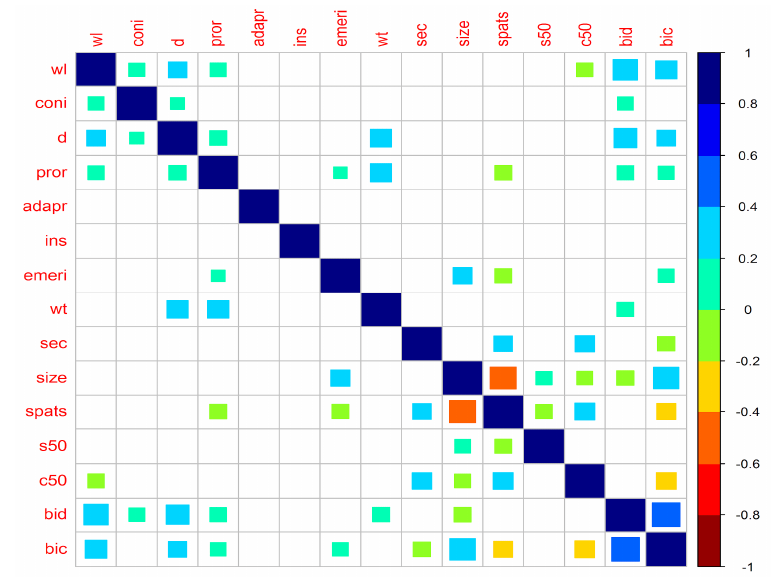
Figure 4. Spearman correlation of the 15 variables. Colored boxes: Correlation is significant at the 1% level.